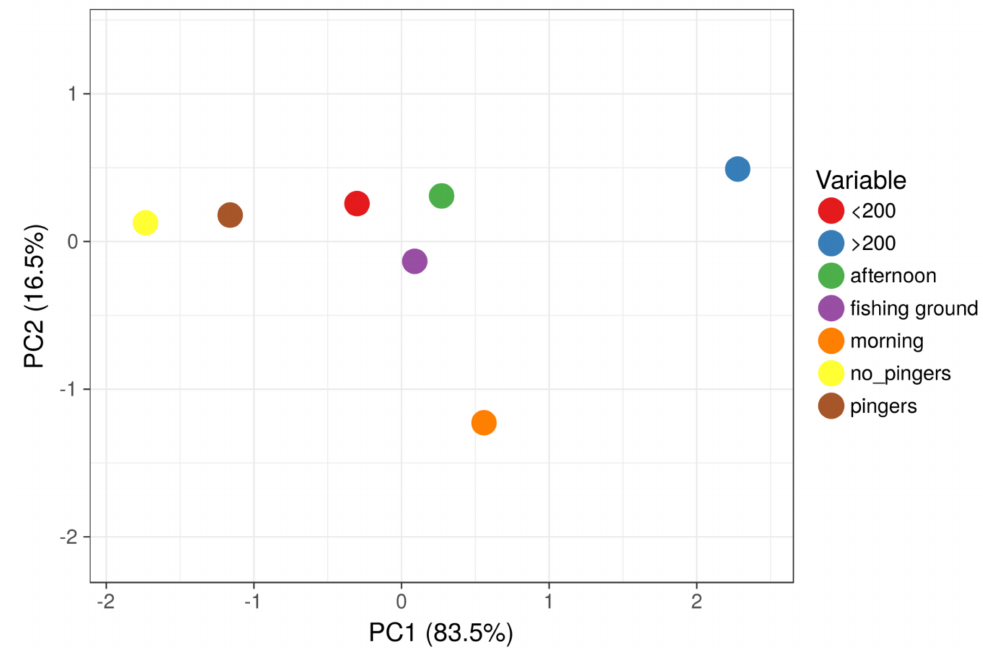
Figure 3. PCA plot on the negative impact on depredation and net damage. Circles represent the frequencies of fishermen responses with respect to depth, fishing ground, time of day, and acoustic